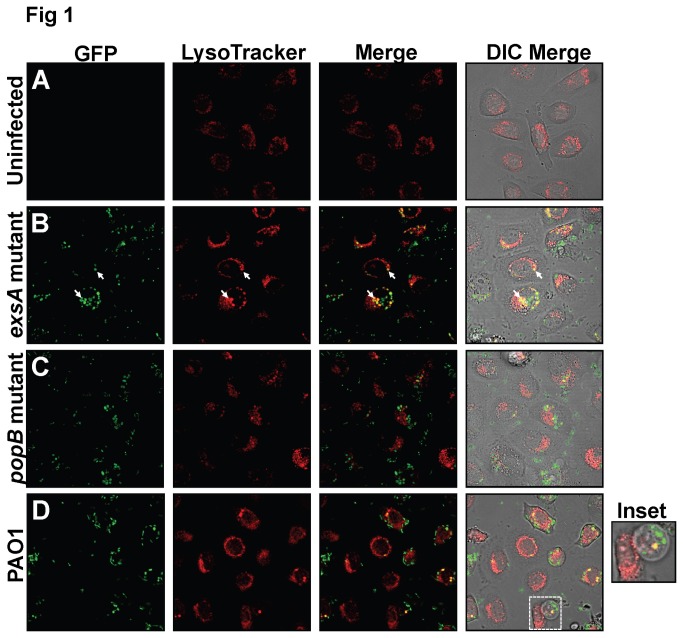
Colocalization of the P. aeruginosa exsA mutant with acidified vacuoles in epithelial cells compared to that of wild-type bacteria or a popB (translocon) mutant.Confocal microscopy images of human corneal epithelial cells at 5 h post-infection with GFP-expressing P. aeruginosa (green). Prior to imaging, infected cultures were infused with LysoTracker (LT) DND-22 (pseudo-colored red). Panels depict (A) Uninfected control, (B) PAO1 exsA mutant (C) PAO1 popB (translocon) mutant and (D) wild-type PAO1. Uninfected cells appeared healthy. The intracellular exsA mutant appeared more frequently in LT (+) (acidified) vacuoles which co-localized yellow (arrows) than either the intracellular popB mutant or wild-type PAO1. PAO1-infected cells which displayed bleb-niche formation (1D inset) showed reduced fluorescence (< 10% fluorescence intensity of PAO1-infected non-blebbing cells, p < 0.001 Welch’s corrected t-Test). Occasional bleb-niches contained LT (+) vacuoles containing bacteria (1D inset, yellow). Representative images are shown. Magnification ~ 600 x.